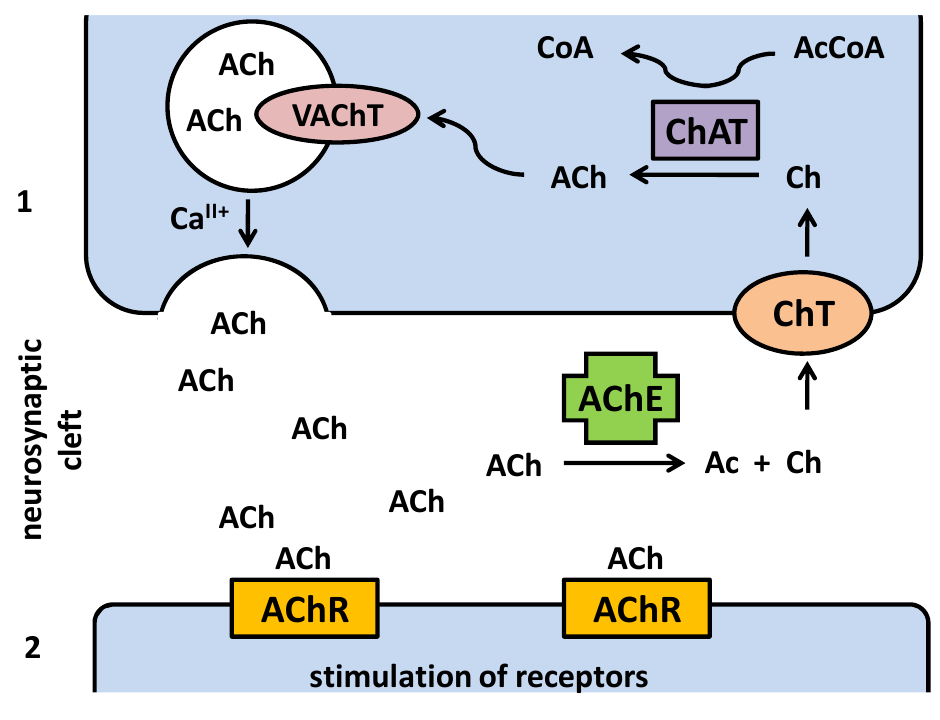
Figure 1. Overview of cholinergic neurotransmission: ACh—acetylcholine;